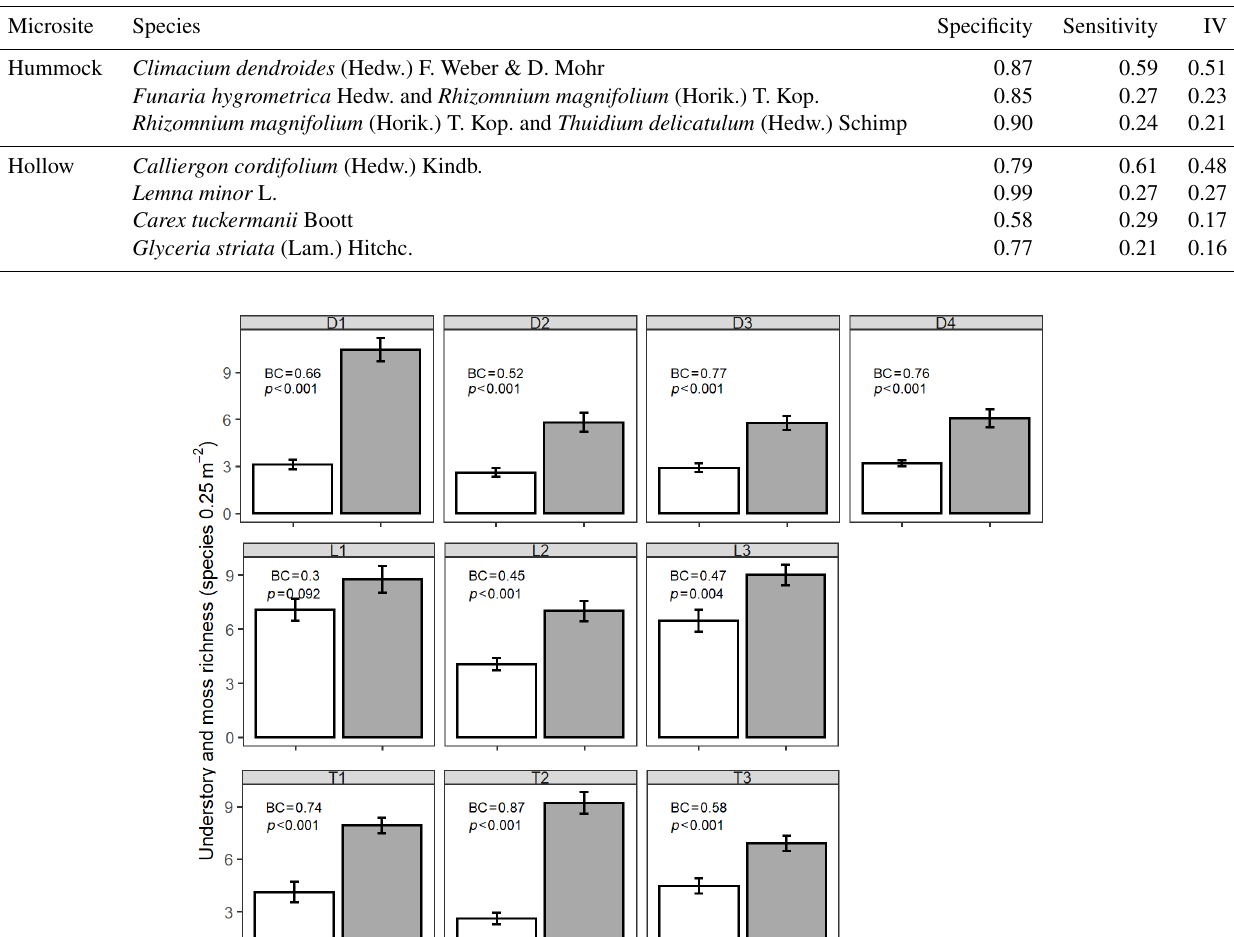
Table 1. Indicator species analysis for hummocks and hollows across sites. Species indicator values (IV) range from 0 to 1 and are the product of specificity and sensitivity conditional probabilities. Specificity is the conditional probability that the sampling point belongs to a particular microsite, given the fact that a particular species was found there, and sensitivity is the conditional probability of finding a particular species in a sampling point, given that the sampling point belongs to a particular microsite.